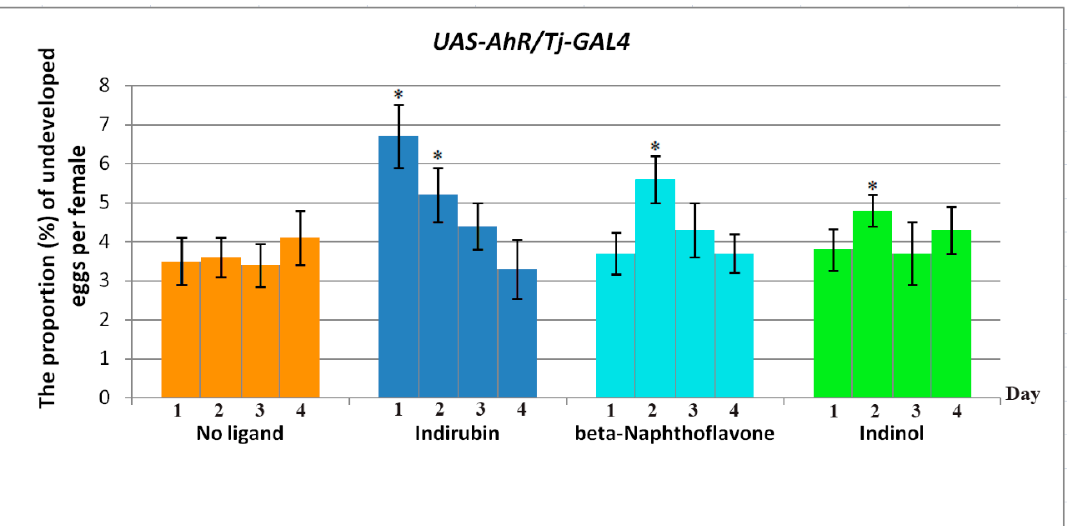
Figure 1. Daily effect of exogenous ligands on the proportion of undeveloped eggs from wild-type female after crossing with UAS-AhR/Tj-GAL4 male without exposure to ligands (control, orange), exposed to indirubin (blue), beta-Naphthoflavone (azure), indinol (green). Data correspond to the mean ± SD of three independent experiments. Asterisks mean the significant difference compared to the control group. Statistical analysis was performed using Student’s t -test (* p ≤ 0.05).